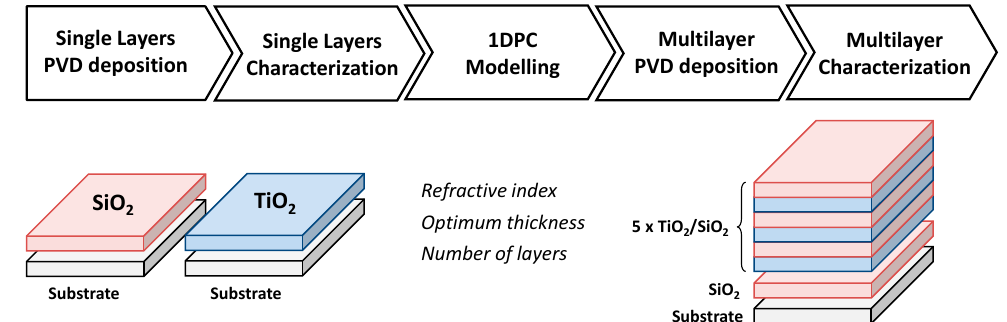
Figure 2. 1DPC manufacturing process: magnetron sputtering deposition (PVD) of single SiO 2 and TiO 2 layers, and their characterization; modeling to find the optimum parameters (thicknesses, sequence, and number of layers stacked); and fi- nally, multilayer magnetron sputtering